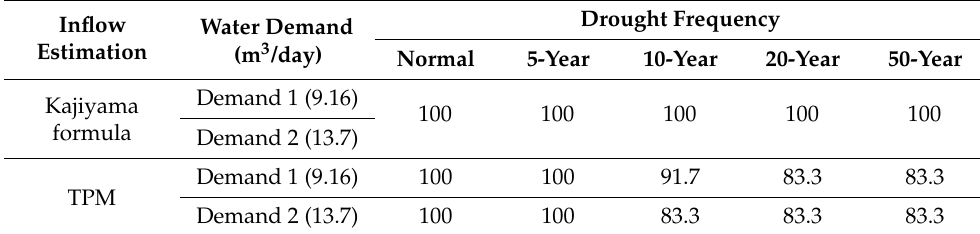
Table 4. Water supply reliability when only the sand dam is operated. A year-round drought is assumed. Inflow